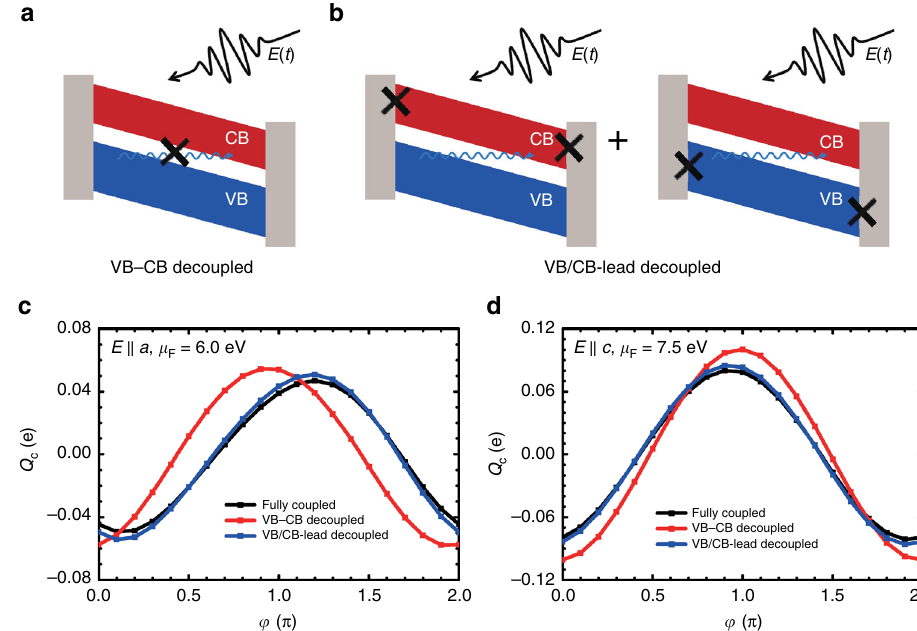
Fig. 7 Importance of Zener tunneling on the photoinduced currents. a , b Scheme of the junction in the presence of an electric fi eld. The wiggly line represents Zener tunneling between the VB and CB. To test its importance two simulation conditions are considered: a Dynamics with Zener tunneling between VB and CB removed (VB-CB decoupled); and b Dynamics obtained by independent electron and hole channels (VB/CB-lead decoupled). The latter is obtained by performing simulations in which only the VB (hole transport) or the CB (electron transport) are connected to the leads and adding their contributions to the total current, as indicated in b . c , d Control map for a N = 6 junction in the two cases depicted in the upper panel for junctions constructed along the c a -direction and d c -direction. The full simulations results are shown in black. Partial or complete suppression of Zener